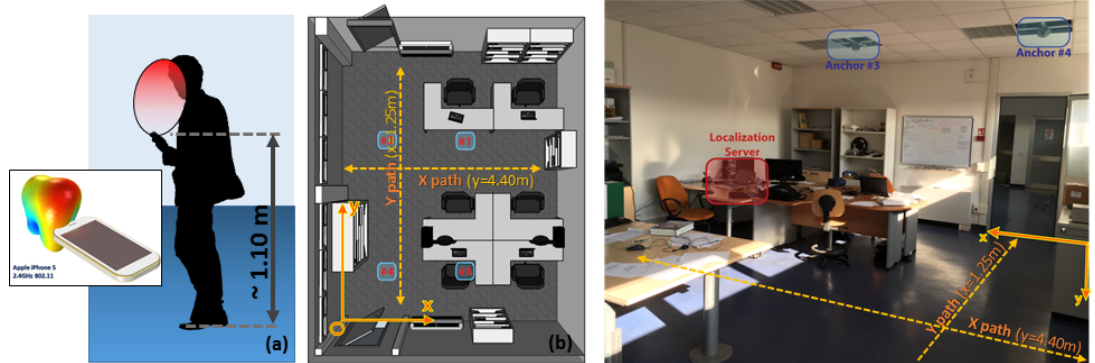
Figure 20. Common standing user posture ( a ) and tracking experiment site and paths ( b